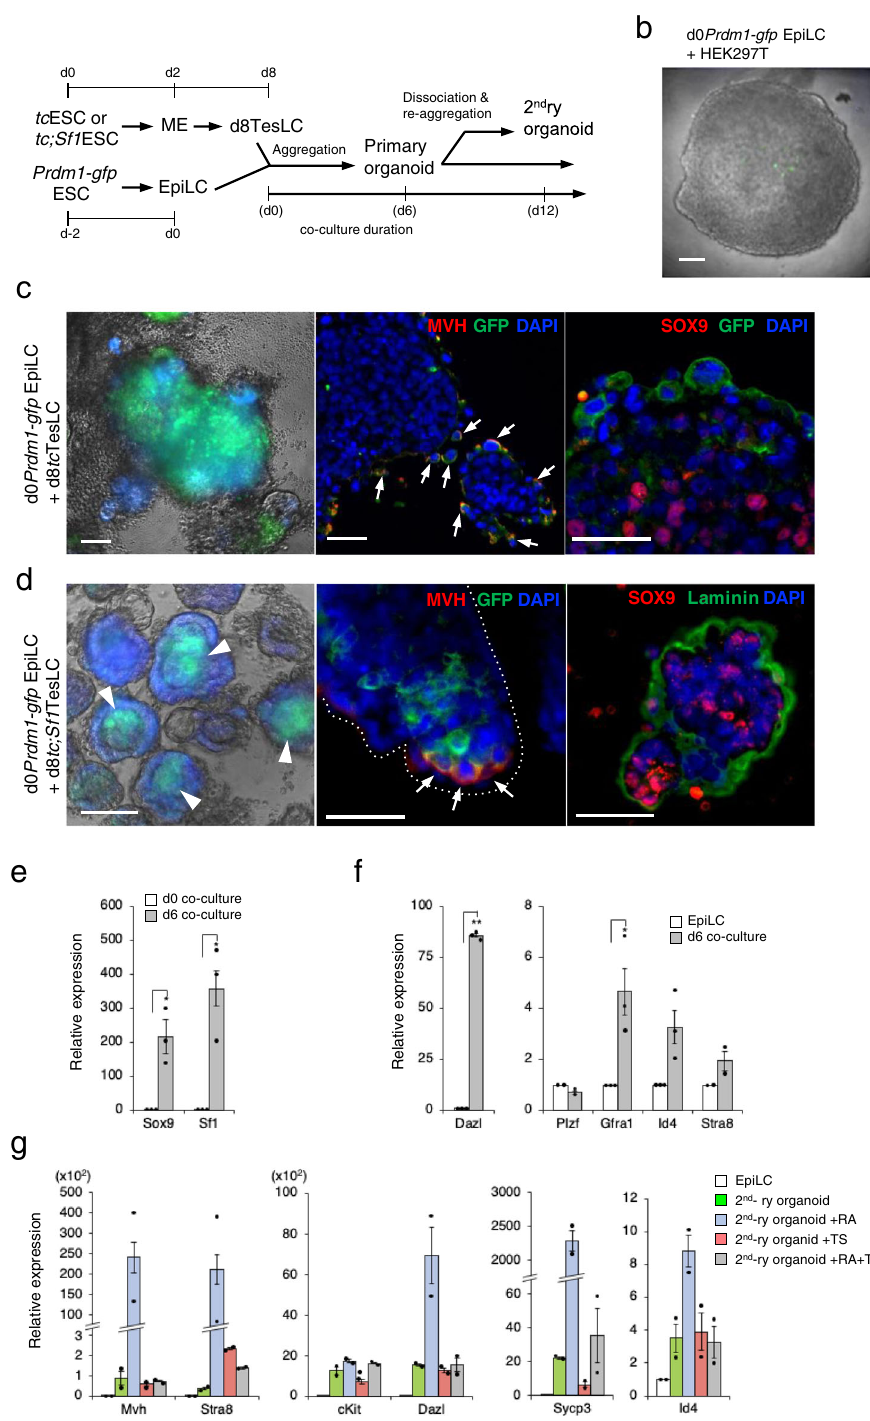
Fig. 3 Formation of a testicular organoid. a Schematic outline of testicular organoid formation by means of aggregation co-culture of d8TesLCs and EpiLCs. b Superimposed images of the aggregation of Prdm1 - gfp EpiLCs with HEK293T cells. c , d Superimposed images of the aggregation of Prdm1 - gfp EpiLCs with d8 tc TesLCs ( c ) or d8 tc;Sf1 TesLCs ( d ) at day 6 of culture and immunohistochemistry for SOX9 (red), MVH (red) laminin (green) and GFP (green). Arrowheads indicate PGCLCs embedded in a seminiferous tubule-like structure composed of SCLCs ( d ). Arrows indicate cells expressing both MVH and GFP. e , f Quantitative RT-PCR analysis for the expression of a Sertoli cell marker Sox9 , a late PGC/gonocyte marker Dazl , SSC markers Gfra1 , Plzf and Id4 , and an early meiotic marker Stra8 in day 6 of aggregate. Fold expression changes relative to day 0 ( e ) or parental EpiLCs ( f ) were calculated by ΔΔ Ct method with standard error. Two to three biological replicates, each of which had three technical replicates, were used for two-sided t -test. ** P < 0.01, * P < 0.05. g , The effect of retinoic acid (RA) and testosterone (TS) on the expression of early PGC ( cKit ), late PGC ( Dazl and Mvh ), SSC ( Id4 ) and early meiotic ( Stra8 and Sycp3) markers in the formation of the secondary aggregate. n = 2 biological replicates, each of which had three technical replicates. DAPI (blue) for nuclear staining. Scale bar, 50 μ